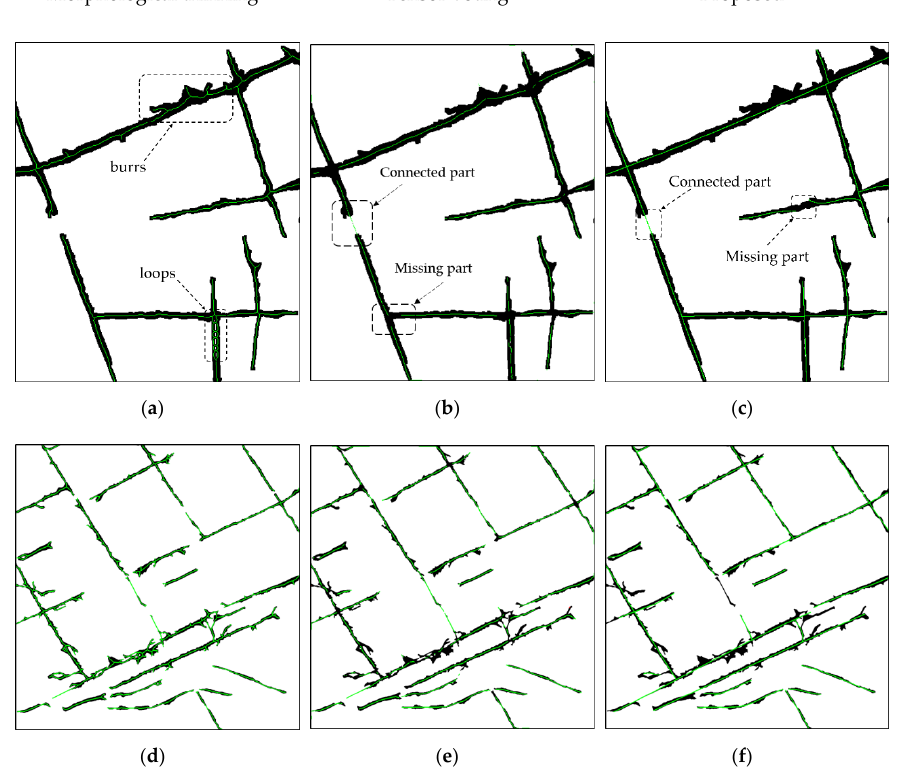
Figure 11. Comparison of network generation results with morphology thinning, tensor voting, and proposed method: ( a – c ) test image 1; ( d – f ) test image 2.